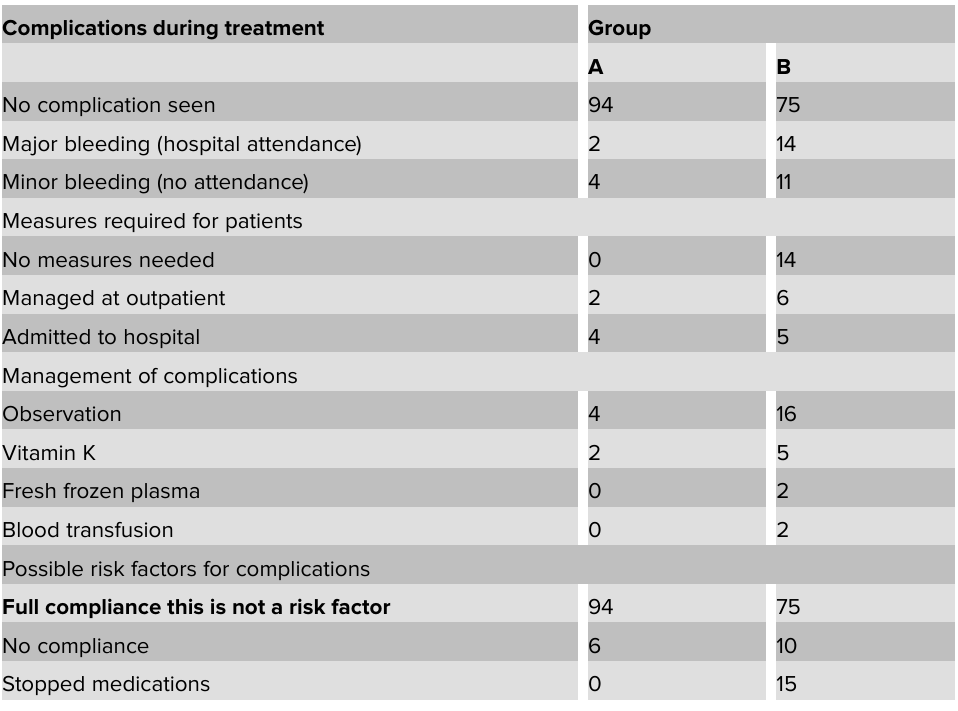
Table 2: The complications and management percent of warfarin therapy in patients on regular follow up in INR-C (group A) and General-C (group B).